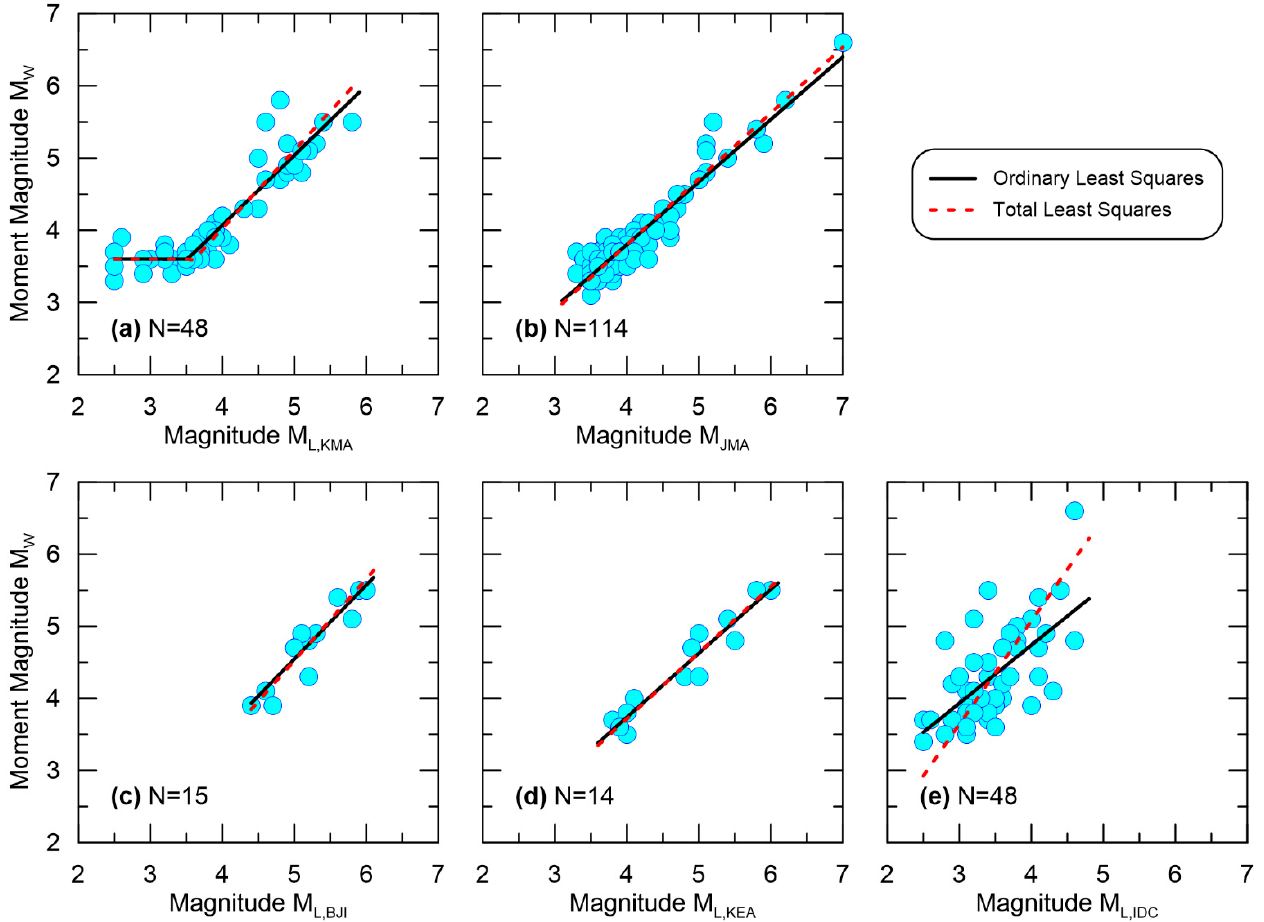
Figure 4. Relationships between M w against M L from ( a ) KMA, ( b ) JMA, ( c ) BJI, ( d ) KEA, and ( e ) IDC. The solid and dashed lines represent the regression type as indicated in the graph. N is the number of data points used for regression.